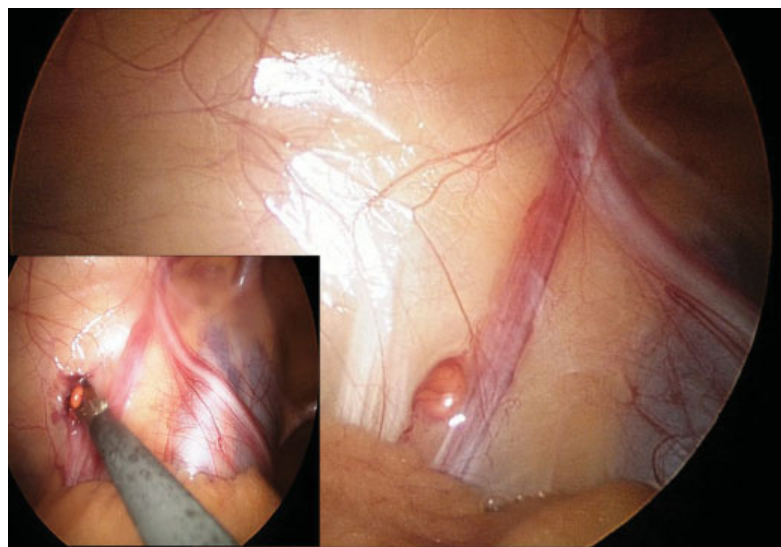
Fig. 1 Laparoscopic appearance of ectopic adrenocortical tissue covered by peritoneum and its excision using a 3-mm operative trocar.